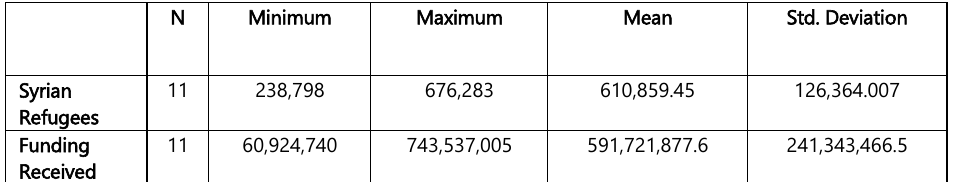
Table 1: Descriptive Analysis (Source: Author‘s research 2022) N Minimum Maximum Mean Std. Deviation